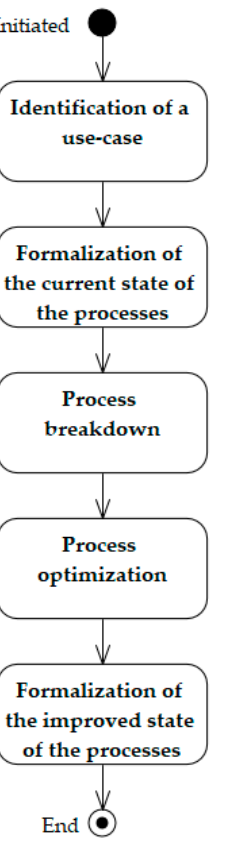
Figure 2. Methodology used for modeling LA data dissemination processes. Source: Own compila- tion.